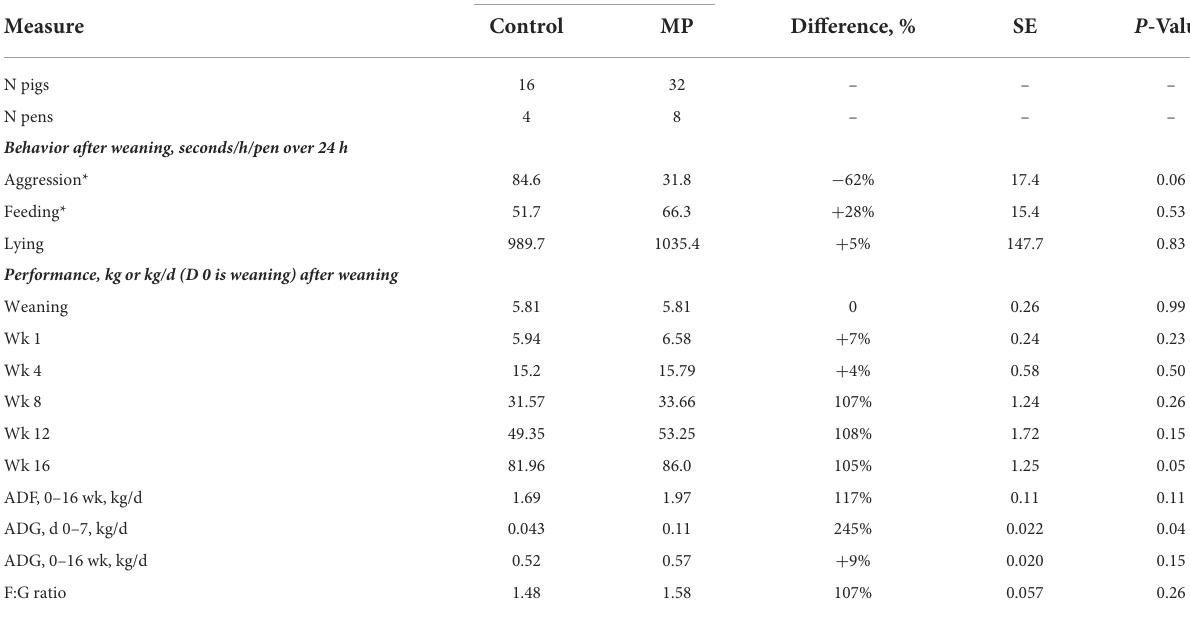
TABLE 3 Study 1 pig behavior (over 24h post-weaning) and performance (weaning until 16 wk